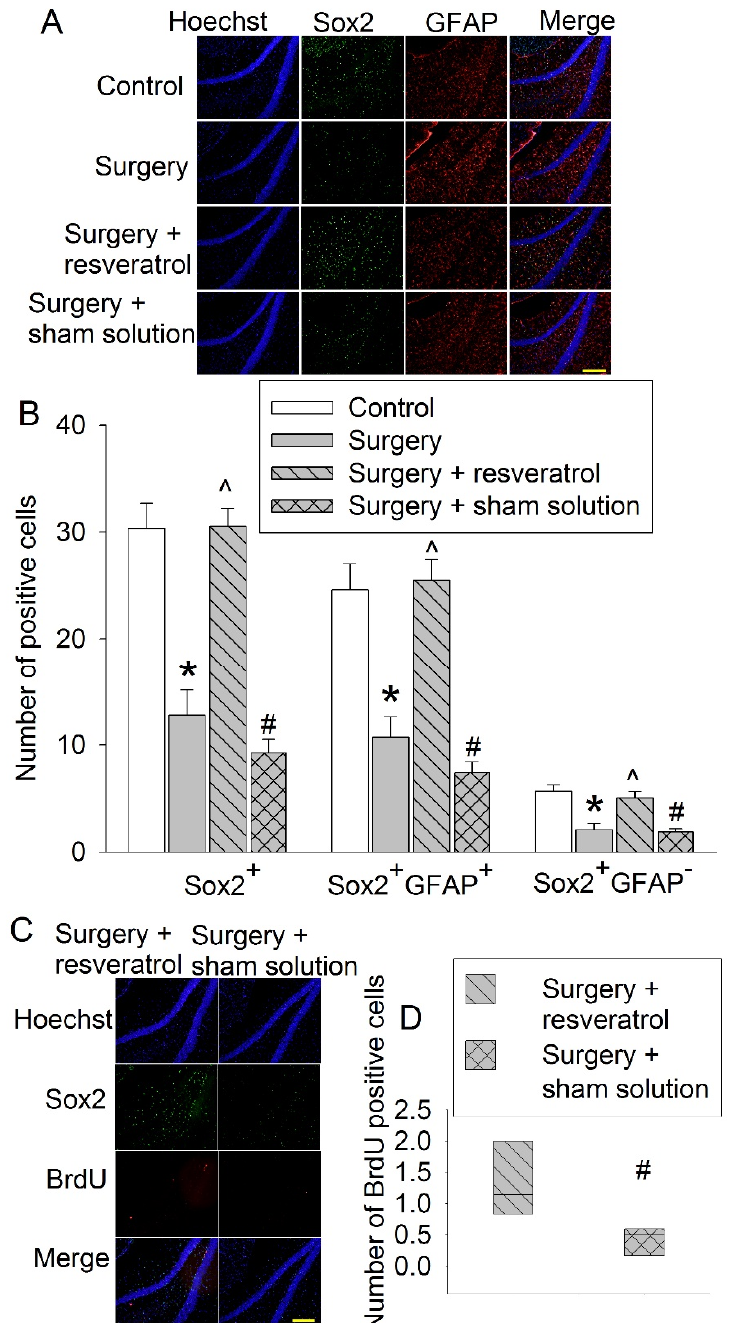
maze test. ( C ) Performance in the fear-conditioning test. Results are means ± S.E.M. ( n = 9–11). # p < 0.05 compared with the corresponding data on day 1, * p < 0.05 compared with control, ^ p < 0.05 compared with surgery group.